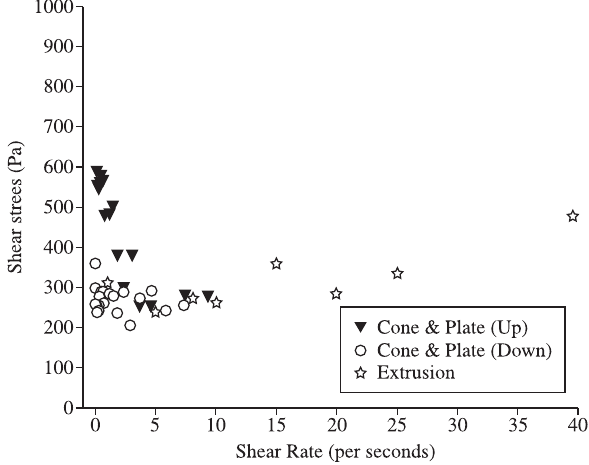
Figure 3. Shear stress as a function of shear rate of sample 1, measured using cone and plate rheometer and capillary extrusion.